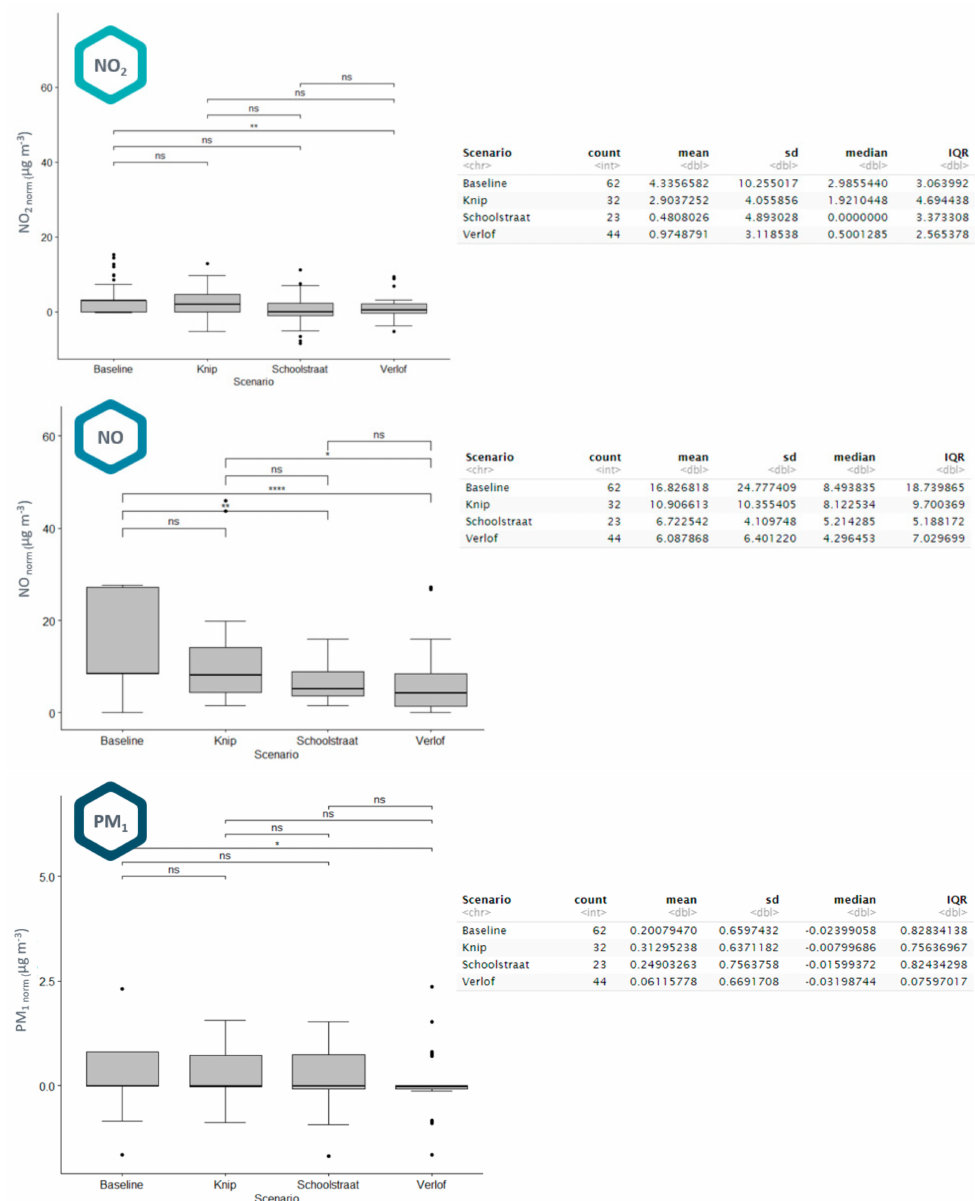
Figure 8. Boxplots with associated Wilcoxon Rank scores (*: p < 0.05, **: p < 0.01, ****: p < 0.001) for the local contribution of NO 2 (upper), NO (middle) and PM 1 (lower) exhibited at the school location during school opening/closing hours (n = 161). Associated descriptive statistics (n, mean, standard deviation (sd), median and interquartile range (IQR)) are provided next to each